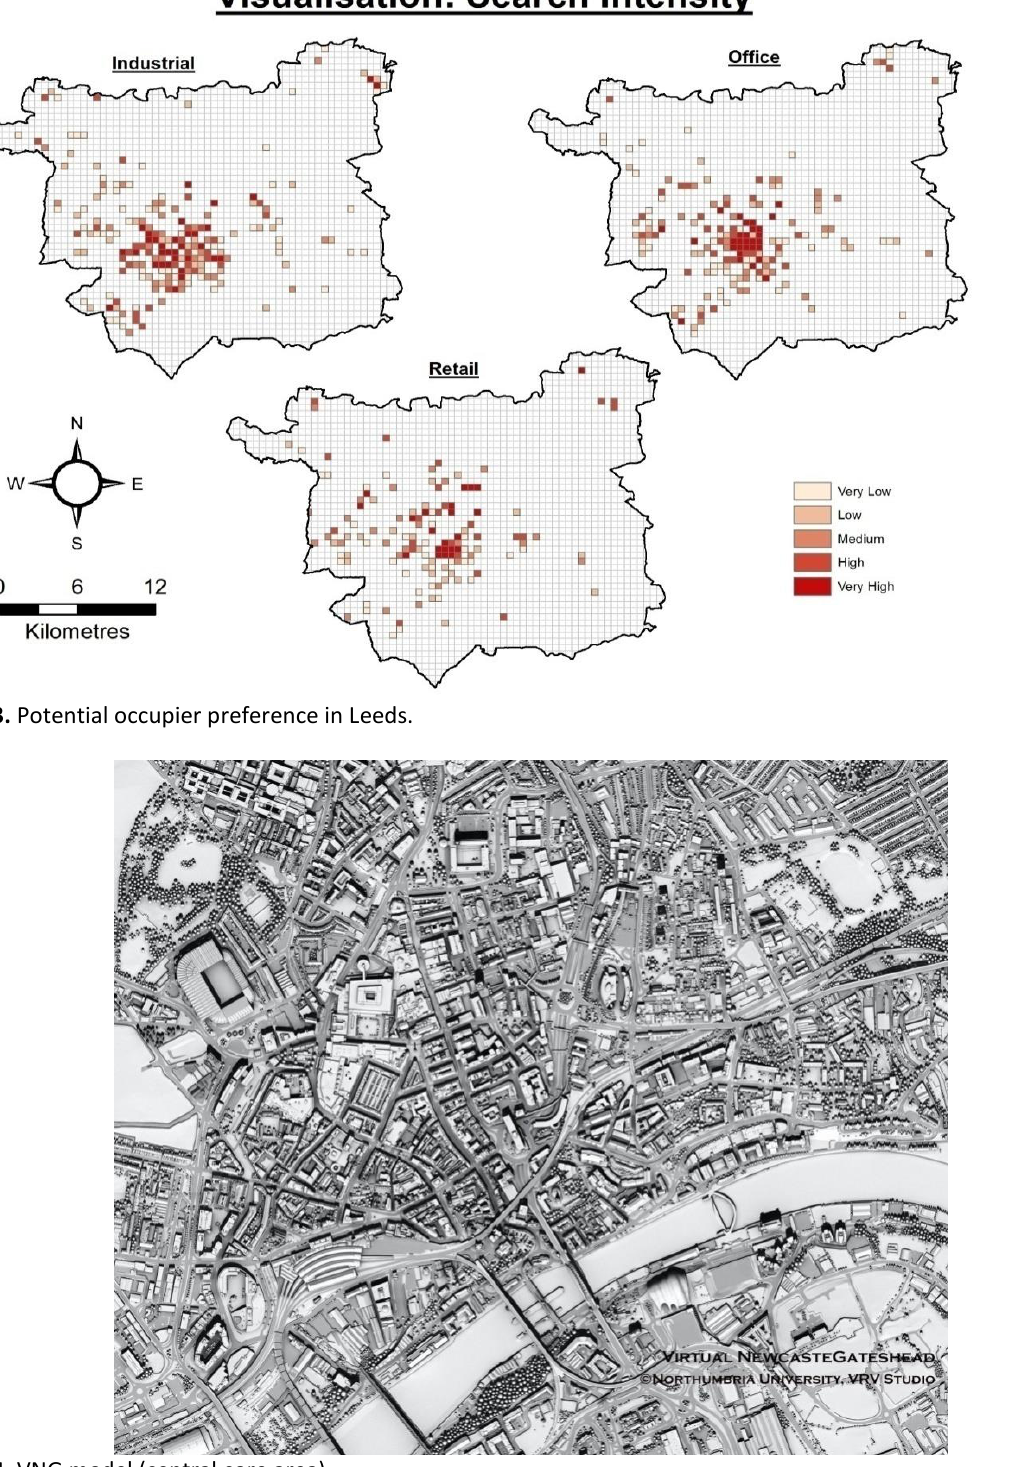
Figure 4. VNG model (central core